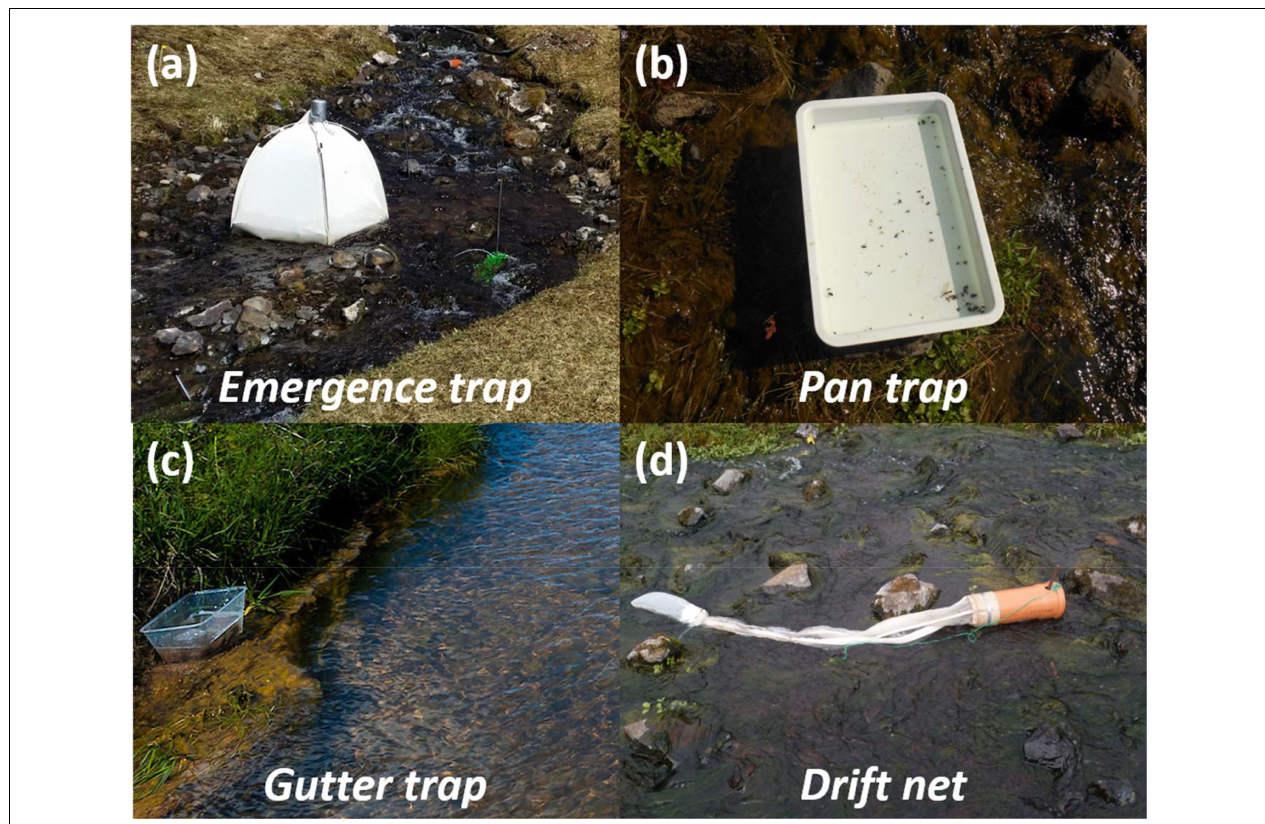
FIGURE 2 | Photos of the traps used to sample reciprocal subsidies between the freshwater and terrestrial environments. (a) Emergence traps intercepted aquatic larvae emerging as adult flies into the terrestrial landscape. (b) Pan traps quantified terrestrial adult flies landing on the surface of the streams. (c) Gutter traps captured ground–dwelling invertebrates falling from the banks into the streams. (d) Drift nets collected terrestrial invertebrates drifting down the